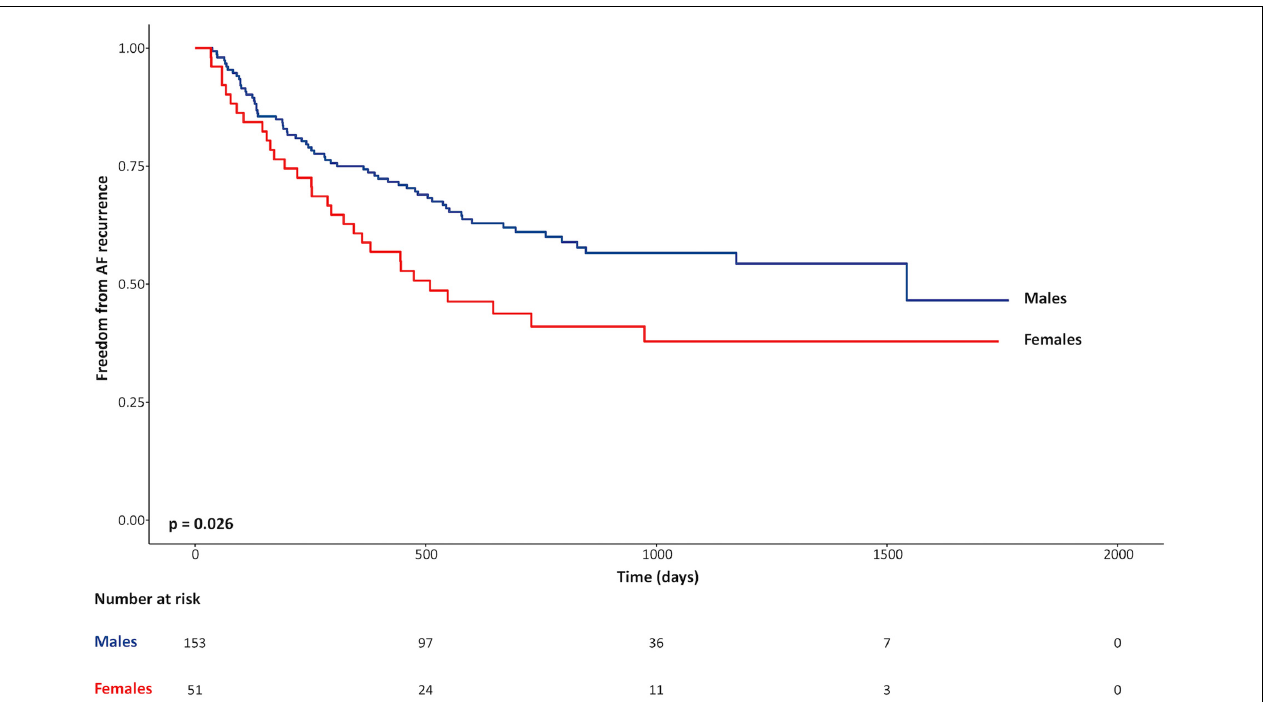
FIGURE 1 | Kaplan-Meier curves for freedom from recurrence of atrial fibrillation for females vs. males.